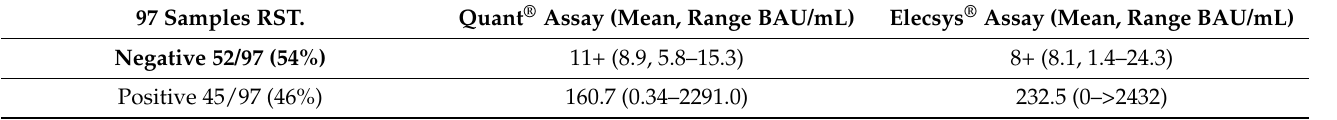
Table 3. Concordance of the seroconversion after two doses between a rapid serological test (RST), Elecsys Quant ® Assay (Abbott) and the Quant ® Assay (Roche), with a gradation of the reference titers (neutralization test 50%, 60, 120 and 300